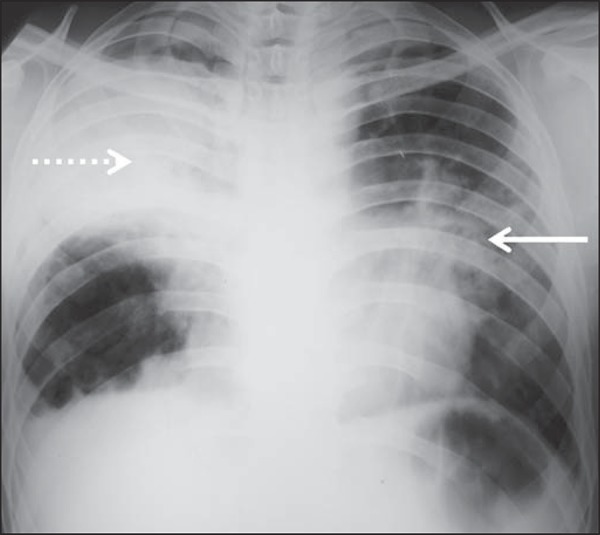
A 41-year-old man with heterogeneous (bold arrow) and homogeneous (dashed arrow)
pulmonary consolidations in the left and right hemithoraces, respectively.